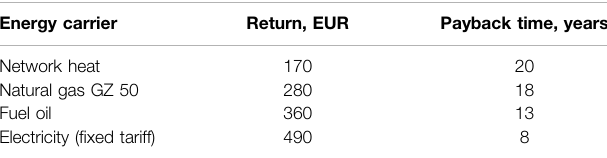
TABLE 3 | Pro fi t obtained from saving of different conventional energy carriers for one year and the payback time in the event of the replacement of different conventional energy carriers.